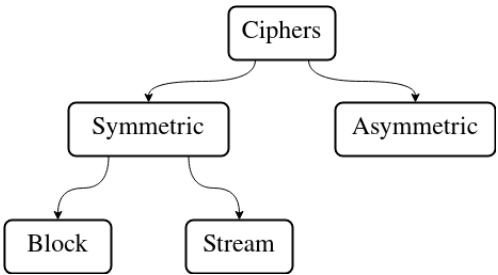
Figure 1. Types of